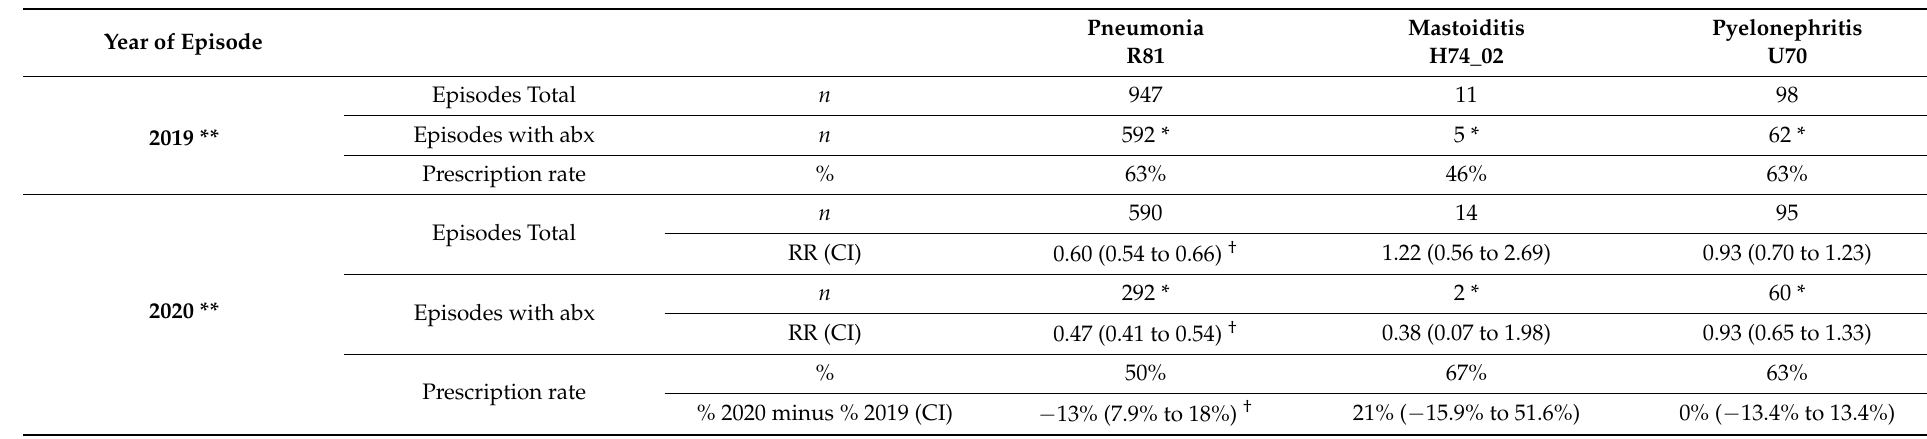
Table 4. Complications, total number of episodes and episodes with antibiotic